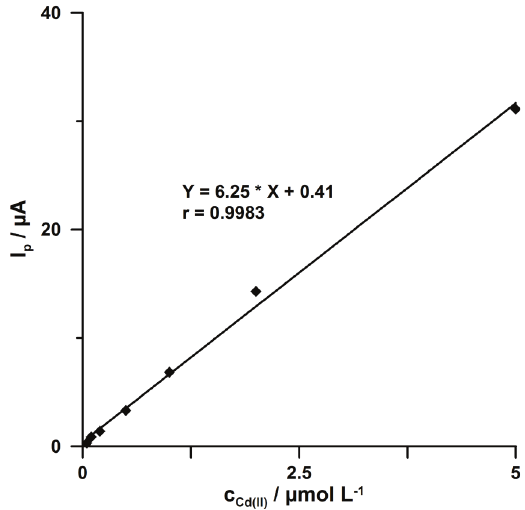
Table 2: Results of Cd(II) determination at an in situ plated lead film scree-printed carbon electrode in Bystrzyca River